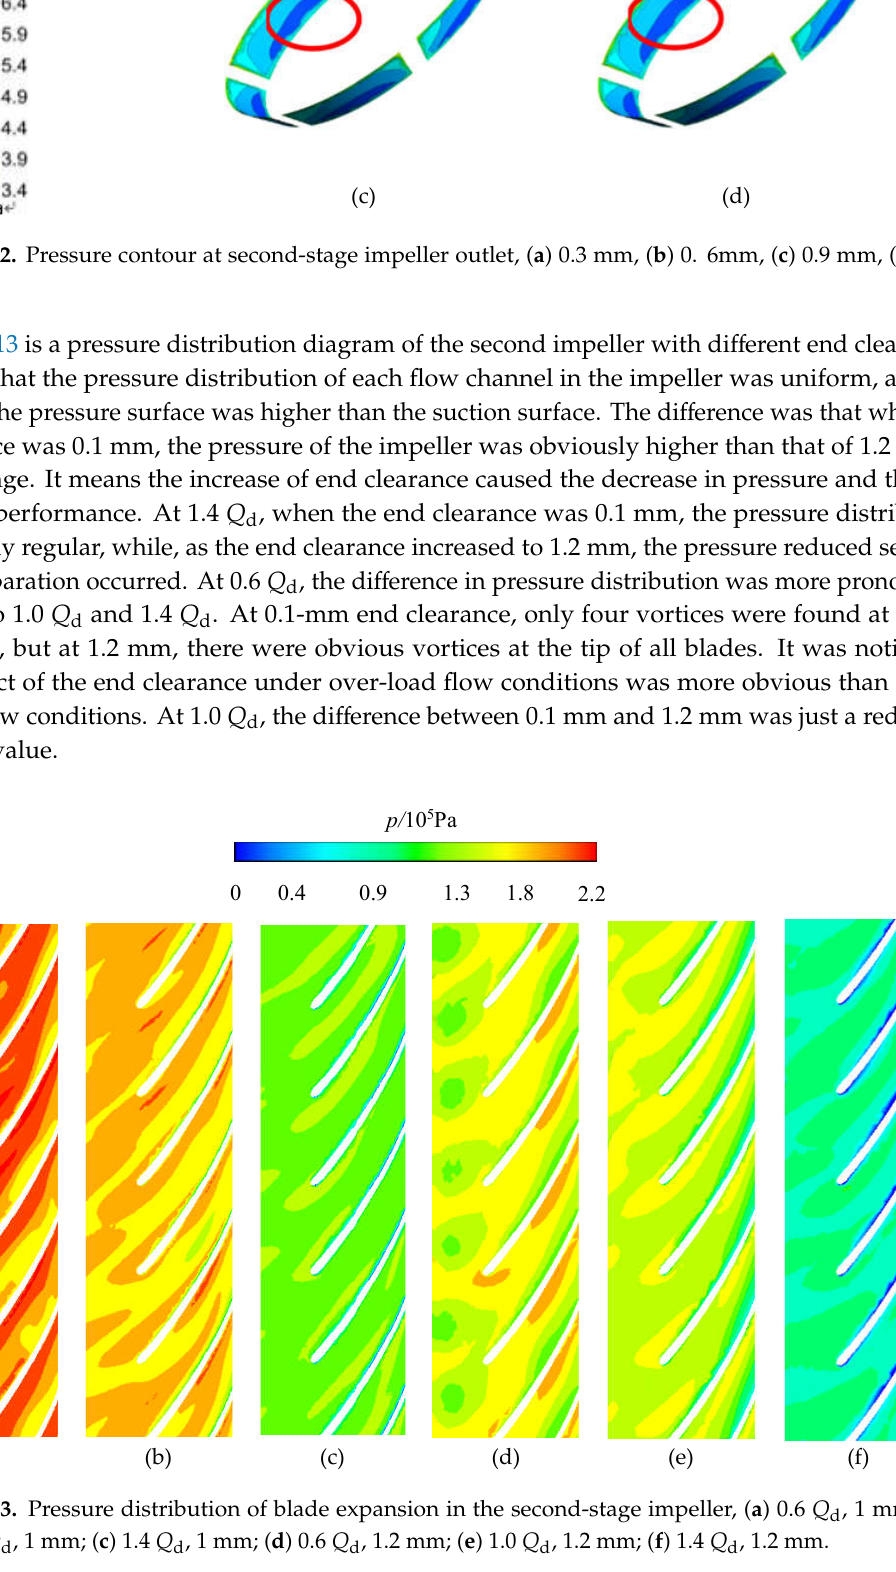
Figure 13. Pressure distribution of blade expansion in the second-stage impeller, ( a ) 0.6 Q d , 1 mm; ( b ) 1.0 Q d , 1 mm; ( c ) 1.4 Q d , 1 mm; ( d ) 0.6 Q d , 1.2 mm; ( e ) 1.0 Q d , 1.2 mm; ( f ) 1.4 Q d , 1.2 mm.